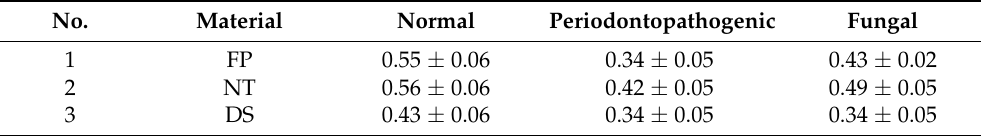
Table 3. The adhesion indices of the normal, periodontopathogenic, and fungal microbiota to the materials under